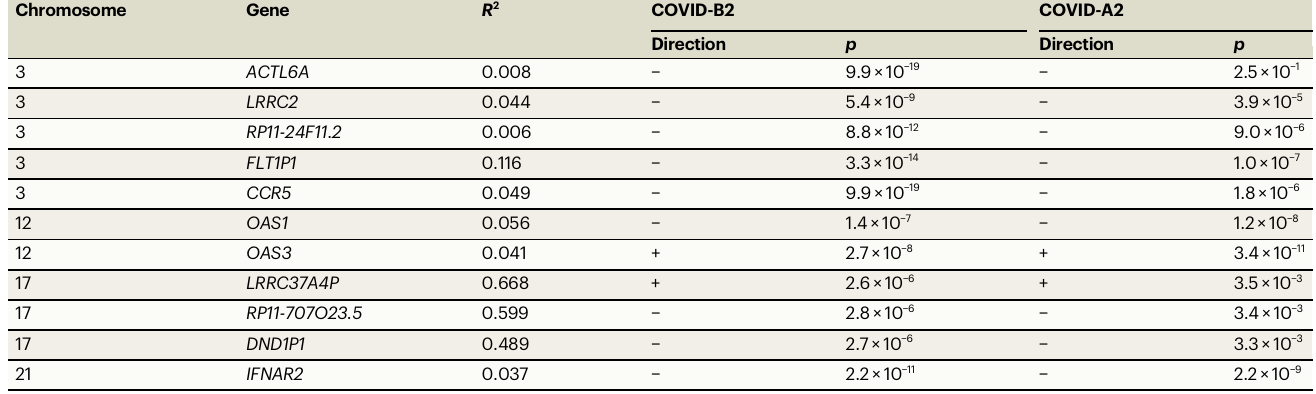
Table 1 | Predicted gene expression in blood-COVID-19 associations for likely causal genes based on COVID-19 Host Genetics Initiative data